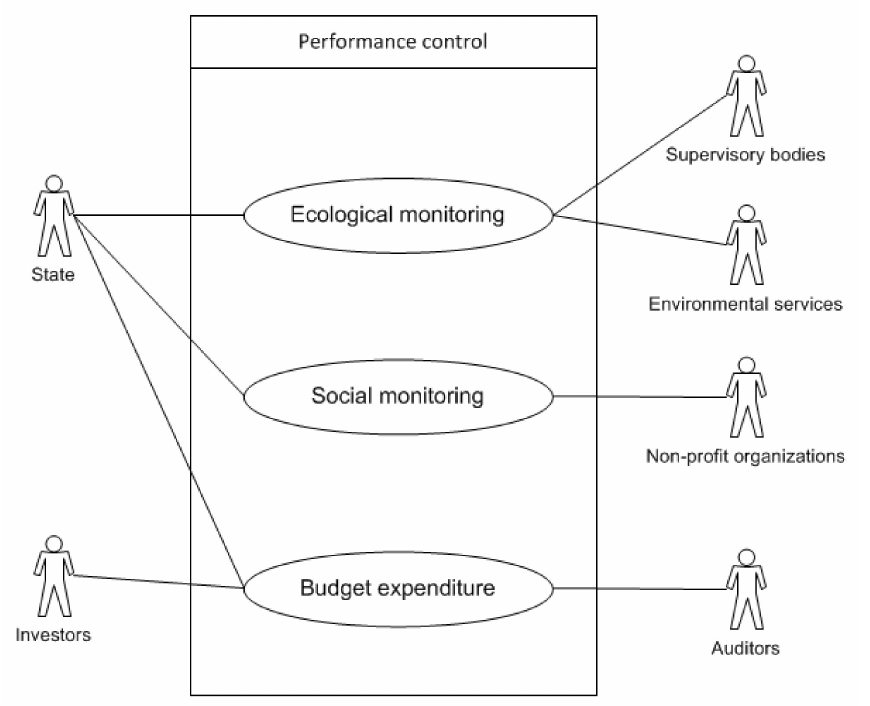
Figure 5. Performance control of operations.